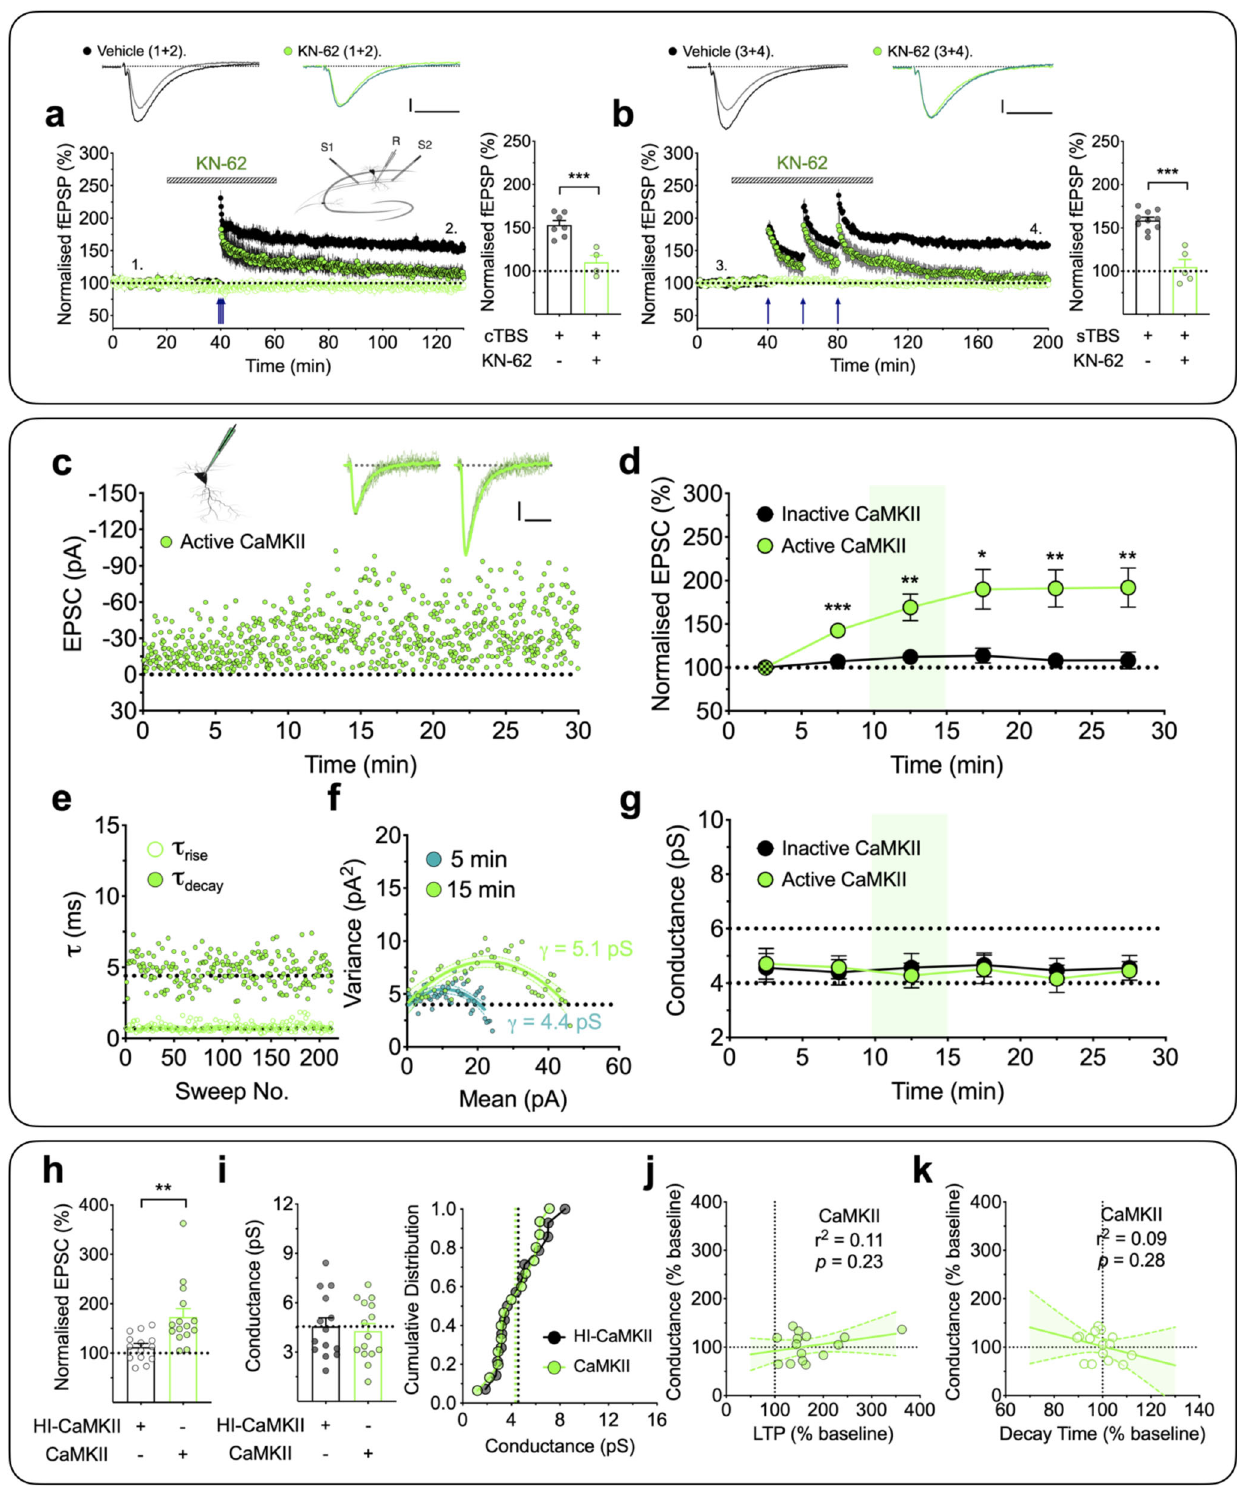
(Fig. 7c, d). The level of γ in KO neurons was signi fi cantly higher